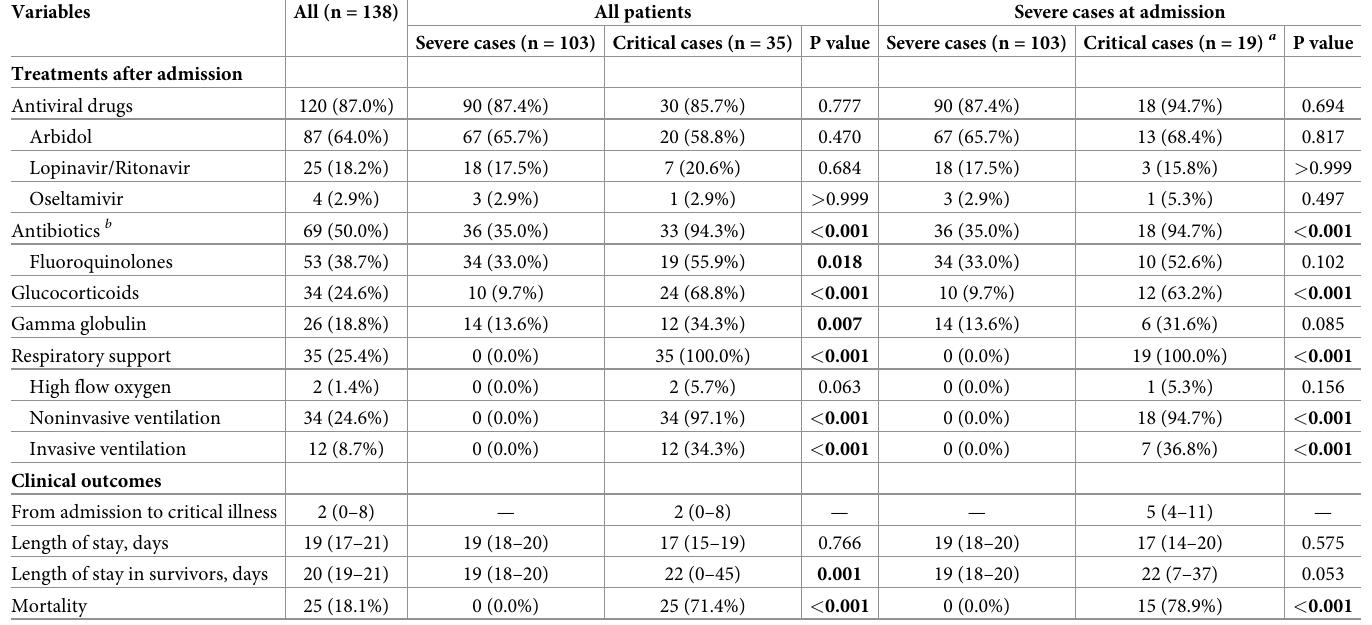
Table 3. Treatments after admission and